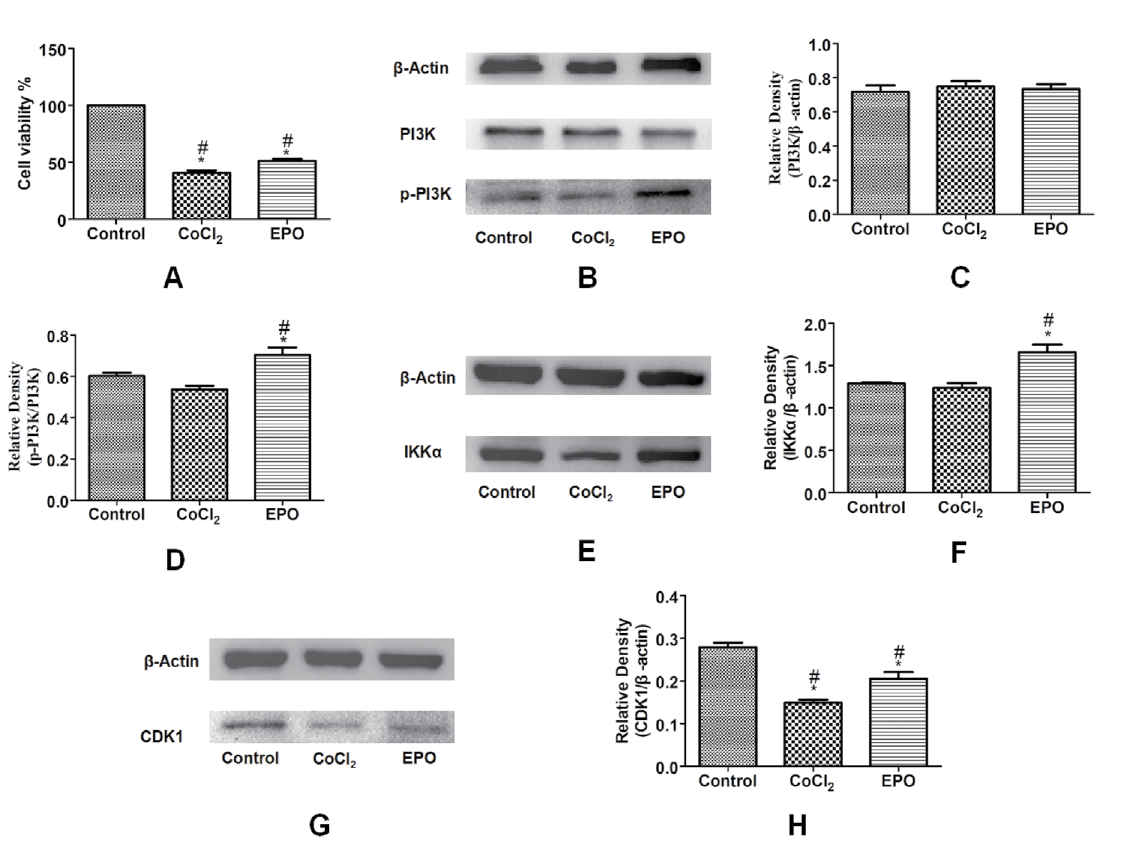
Figure 3 – Effect of EPO on U251 cells under hypoxia. (A) The effect of EPO on the proliferation of U251 cells under hypoxia was determined by CCK-8 assay. # P<0.05 vs. the blank control group.* P<0.05 vs. the CoC1 method. # P<0.05 vs. the blank control group.* P<0.05 vs. the CoC1